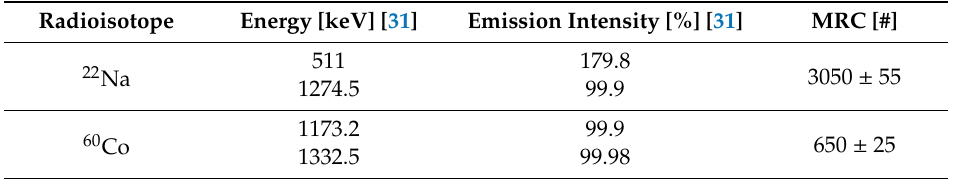
Table 2. Determined minimum reconstructible counts (MRCs) where averaged MAPEs are lower than 10% for each